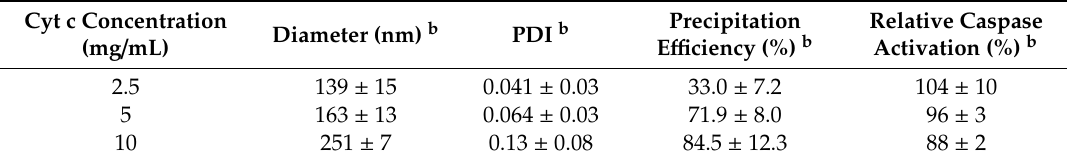
Table 3. E ff ect of Cyt c concentration during nanoprecipitation on NP diameter, PDI, precipitation e ffi ciency, and relative caspase 3, 7, and 10 activation a